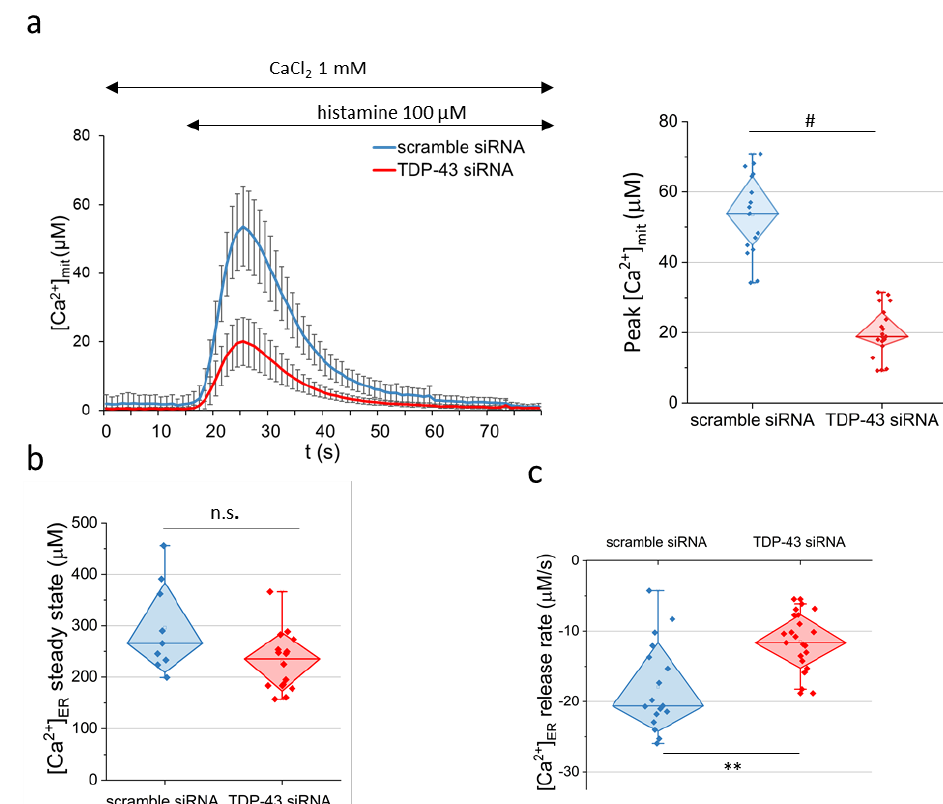
Figure 2. TDP-43 regulates both mitochondria Ca 2+ uptake and ER Ca 2+ discharge in HeLa cells. Ca 2+ transients were measured in TDP-43-silenced or control (scramble) HeLa cells using AEQ probes targeted to the mitochondrial matrix (panel a) or the ER lumen (panels b and c). ( a ) Average kinetics of mitochondrial Ca 2+ transients ([Ca 2+ ] mit ) upon stimulation with histamine (100 µ M) at the indicated time point. Reported traces are mean ± SD (shown on the left). The box plot of the corresponding [Ca 2+ ] peak value is shown on the right. n = 17, scrambled siRNA; n = 19, TDP-43 siRNA. ( b ) The box plot reports the mean value of the luminal [Ca 2+ ] ER steady state (see Materials and Methods). n = 9, scrambled siRNA; n = 16, TDP-43 siRNA; n.s., not significant (Mann–Whitney U test). ( c ) The box plot reports the luminal Ca 2+ rate of release (expressed as µ M/s) upon histamine stimulation (100 µ M). n = 23, scrambled siRNA; n = 17, TDP-43 siRNA. ** p < 0.01; # p < 10 − 7 (Mann–Whitney U test).